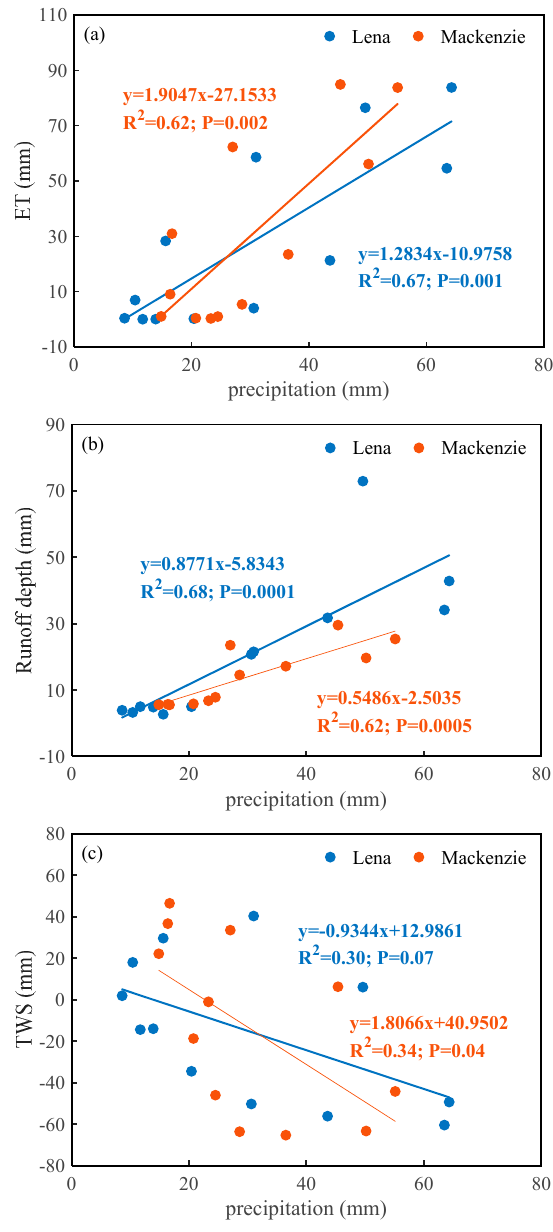
Figure 9. The relationships between the monthly precipitation and ET ( a ), runoff ( b ) and TWS ( c ) in the LRB and MRB.